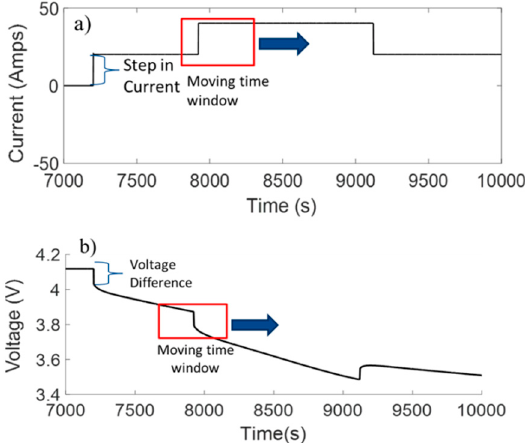
Figure 4. Direct resistance estimation (DRE) approach for estimating ohmic resistance in the battery, where ( a ) is the current profile and ( b ) is the corresponding voltage profile.